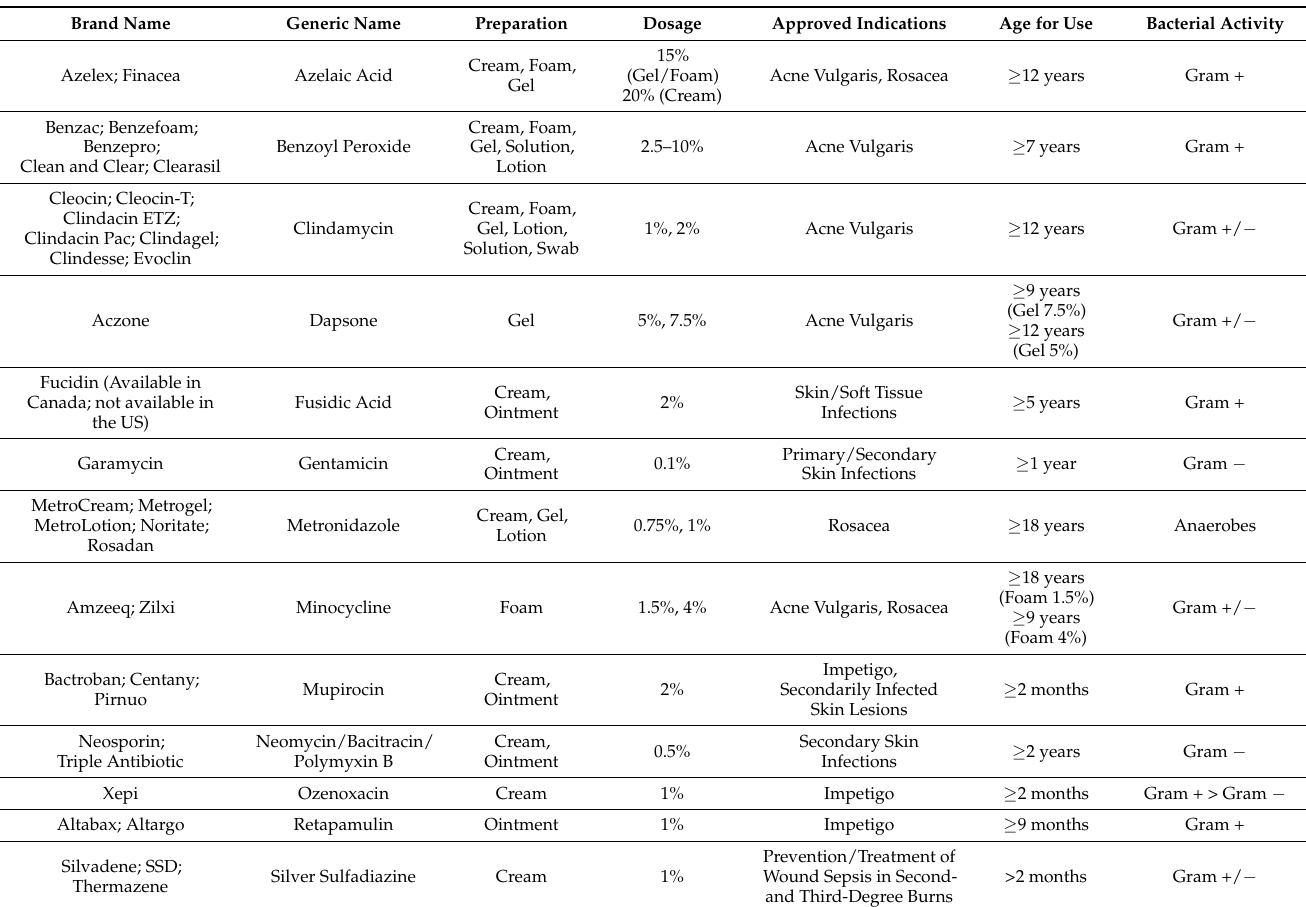
Table 2. Characteristics of topical